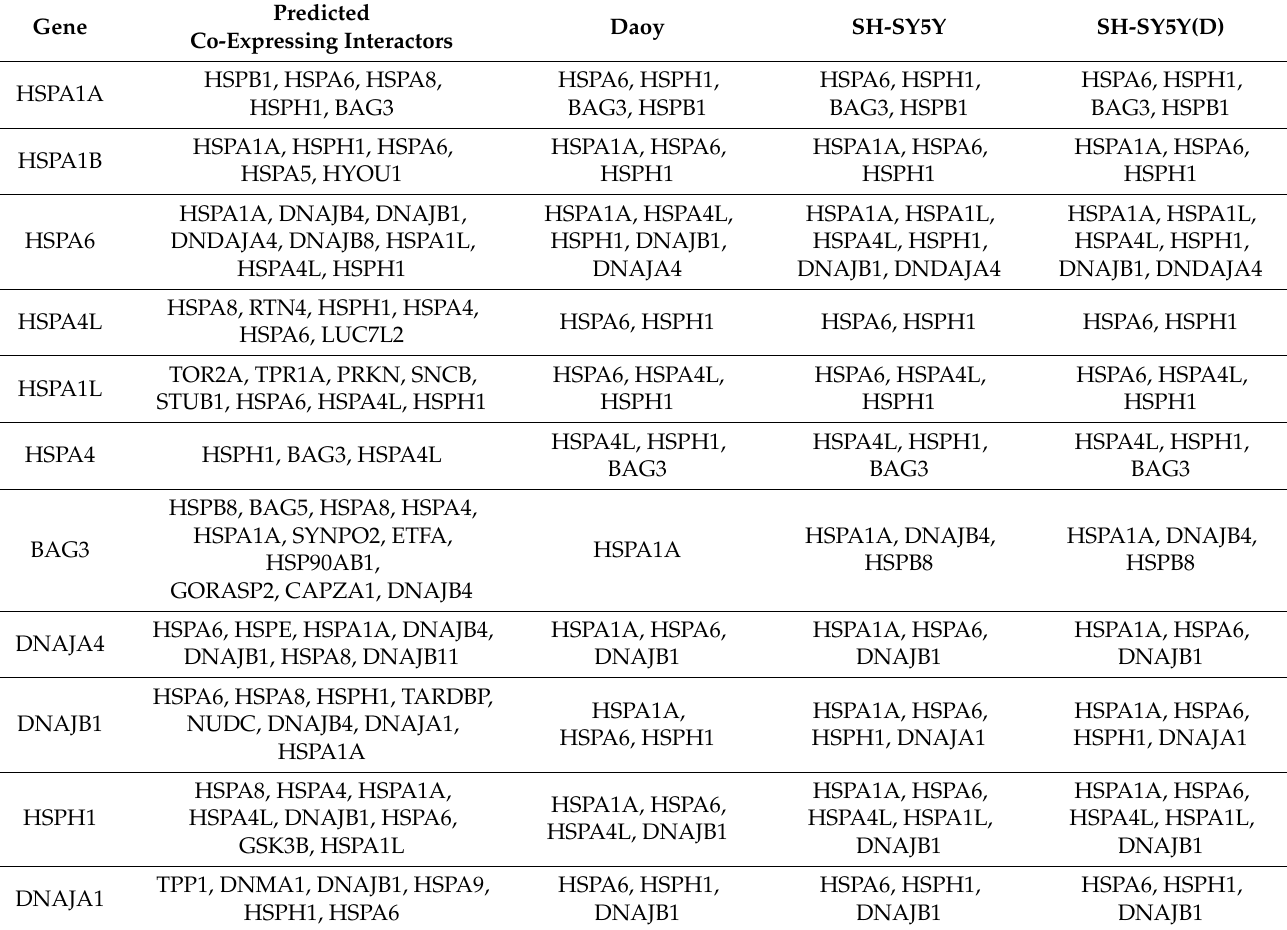
Table 3. Network analysis. GeneMANIA predicted co-expressed interactors of DEGs from the Human Heat Shock Proteins and Chaperones PCR Array and interactors specific to each cell